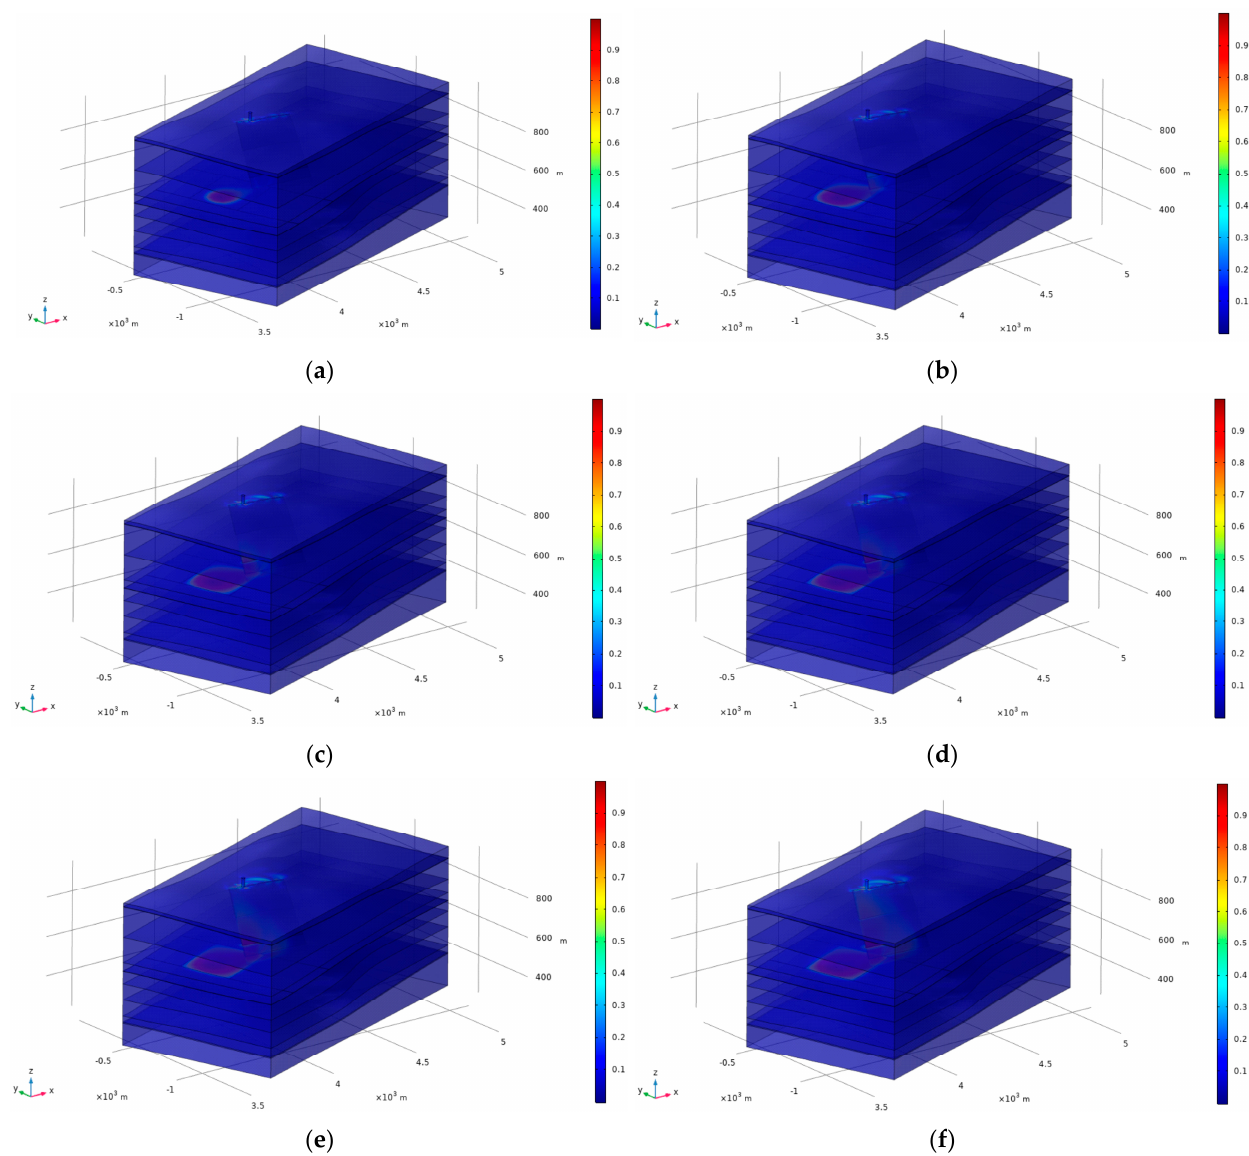
Figure 15. Slurry transport clouds at different times: ( a ) 1d; ( b ) 3d; ( c ) 5d; ( d ) 7d; ( e ) 10d; ( f ) 13d .